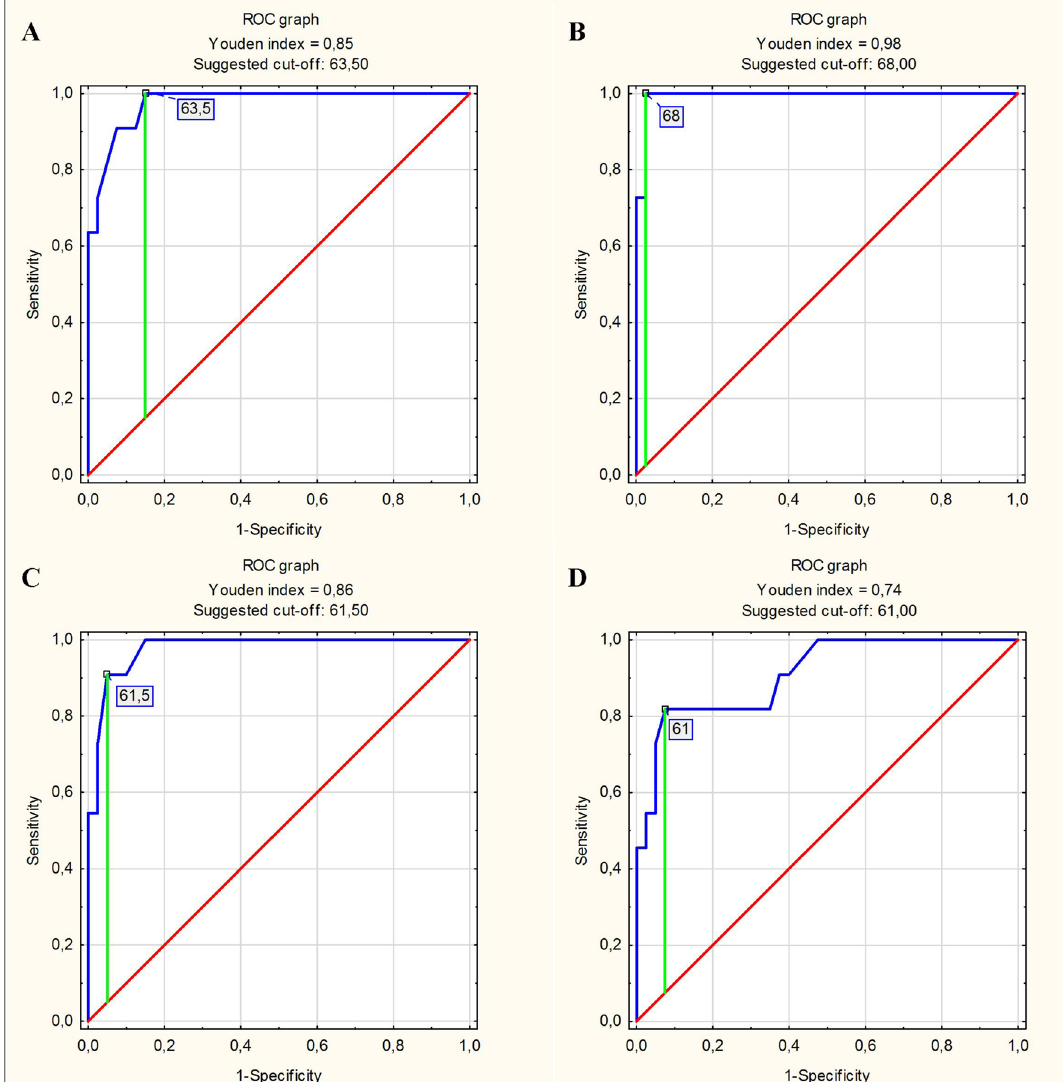
Figure 2. ROC curves determining the optimal cut-off points for left ventricular end-diastolic diameter (LVEDD) measurements in the prediction of left ventricular enlargement diagnosed based on left ventricular end-diastolic volume in the male subgroup: () LVEDD measured in the short axis as a predictor of left ventricular enlargement. ( B ) LVEDD measured in the long axis in the 2-chamber view as a predictor of left ventricular enlargement. ( C ) LVEDD measured in the long axis in the 3-chamber view as a predictor of left ventricular enlargement. ( D ) LVEDD measured in the long axis in the 4-chamber view as a predictor of left ventricular